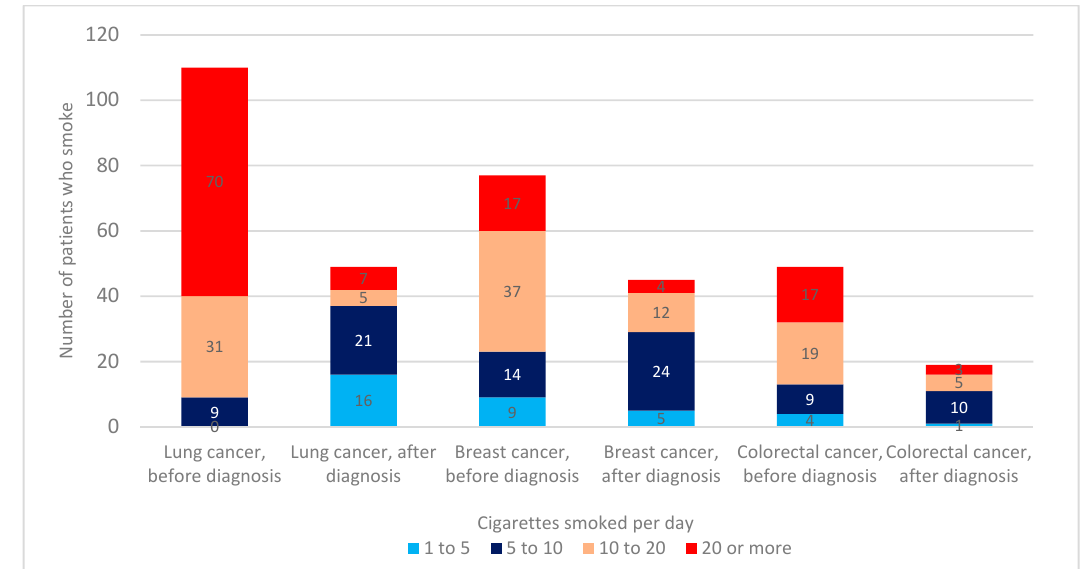
Figure 3. Analysis of the average number of cigarettes smoked per day based on the three most common cancer types at any time before cancer diagnosis and during the cancer treatment. Statistical significance in number of cigarettes smoked is registered both before ( χ 2 = 50.006, p = <0.001; H = 36.926, p = <0.001) and after cancer diagnosis ( χ 2 = 20.498, p = 0.009; H = 7.554, p = 0.023).